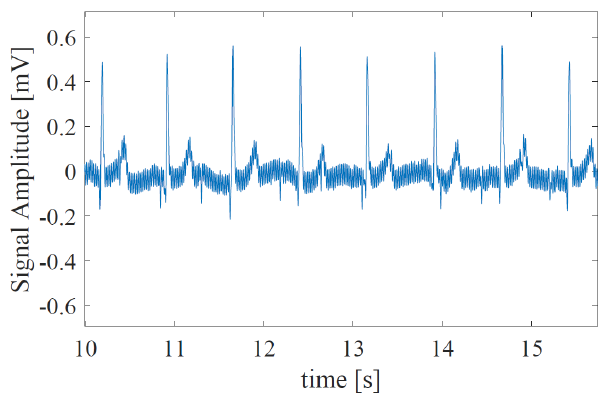
Figure 1. The part of AECG waveform when signal accuracy is relatively